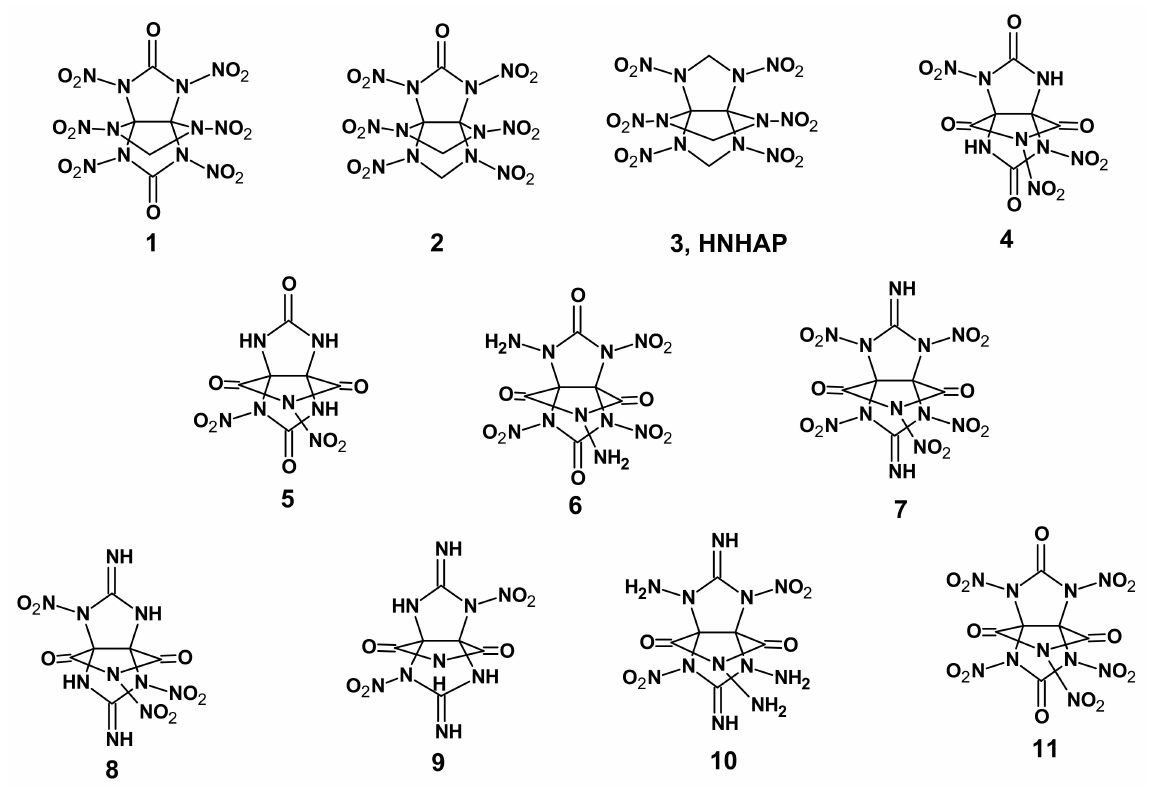
Figure 1. Hypothetical derivatives of the penta- and hexaazapropellane cage. Table 1. Prediction results for explosive characteristics of polynitroaza[3.3.3]propellanes.